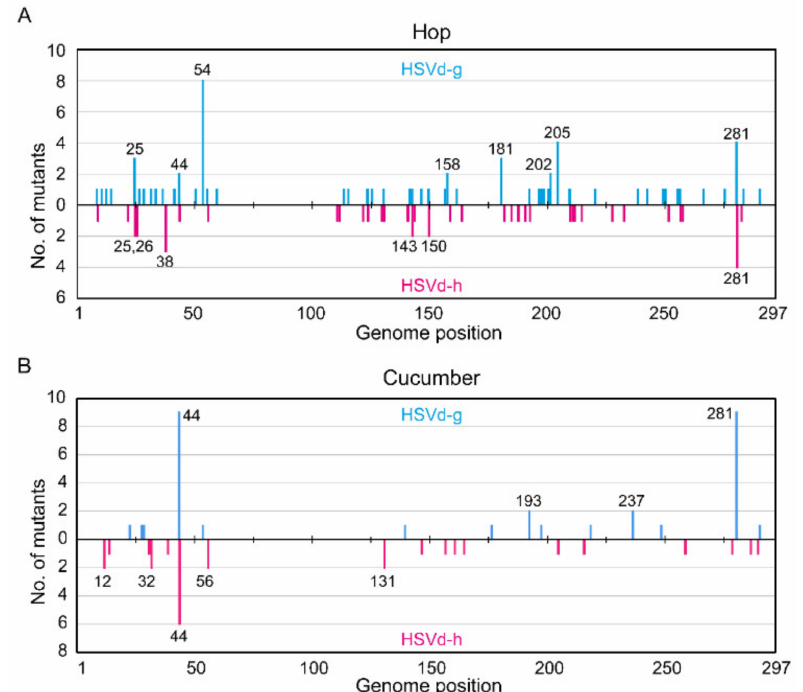
Figure 4. Frequency of mutations in HSVd during the initial stage of replication in ( A ) hop (the second growing season) and ( B ) cucumber (the second passage) plants. The vertical axis indicates the number of cDNA clones containing mutation(s). The numbers of cDNA clones with mutations were plotted along the linearized HSVd genome. Blue bars indicate mutations found in HSVd-g, and red bars indicate those in HSVd-h. The numbers above the bars indicate the nucleotide position of